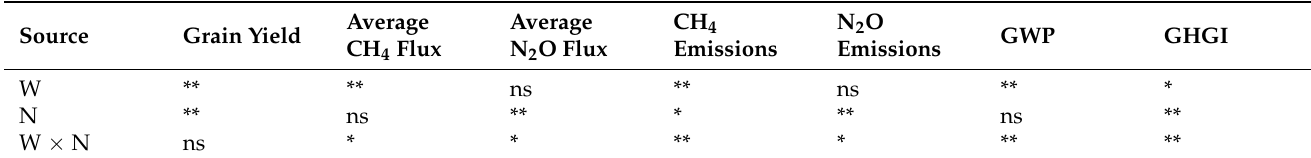
Table 3. Two-way ANOVA analysis of rice yield; average CH 4 and N 2 O flux; and seasonal emis- sions of CH 4 , N 2 O, GWP, and GHGI under N fertilization and water regimes (W), as well as their interactions (n =